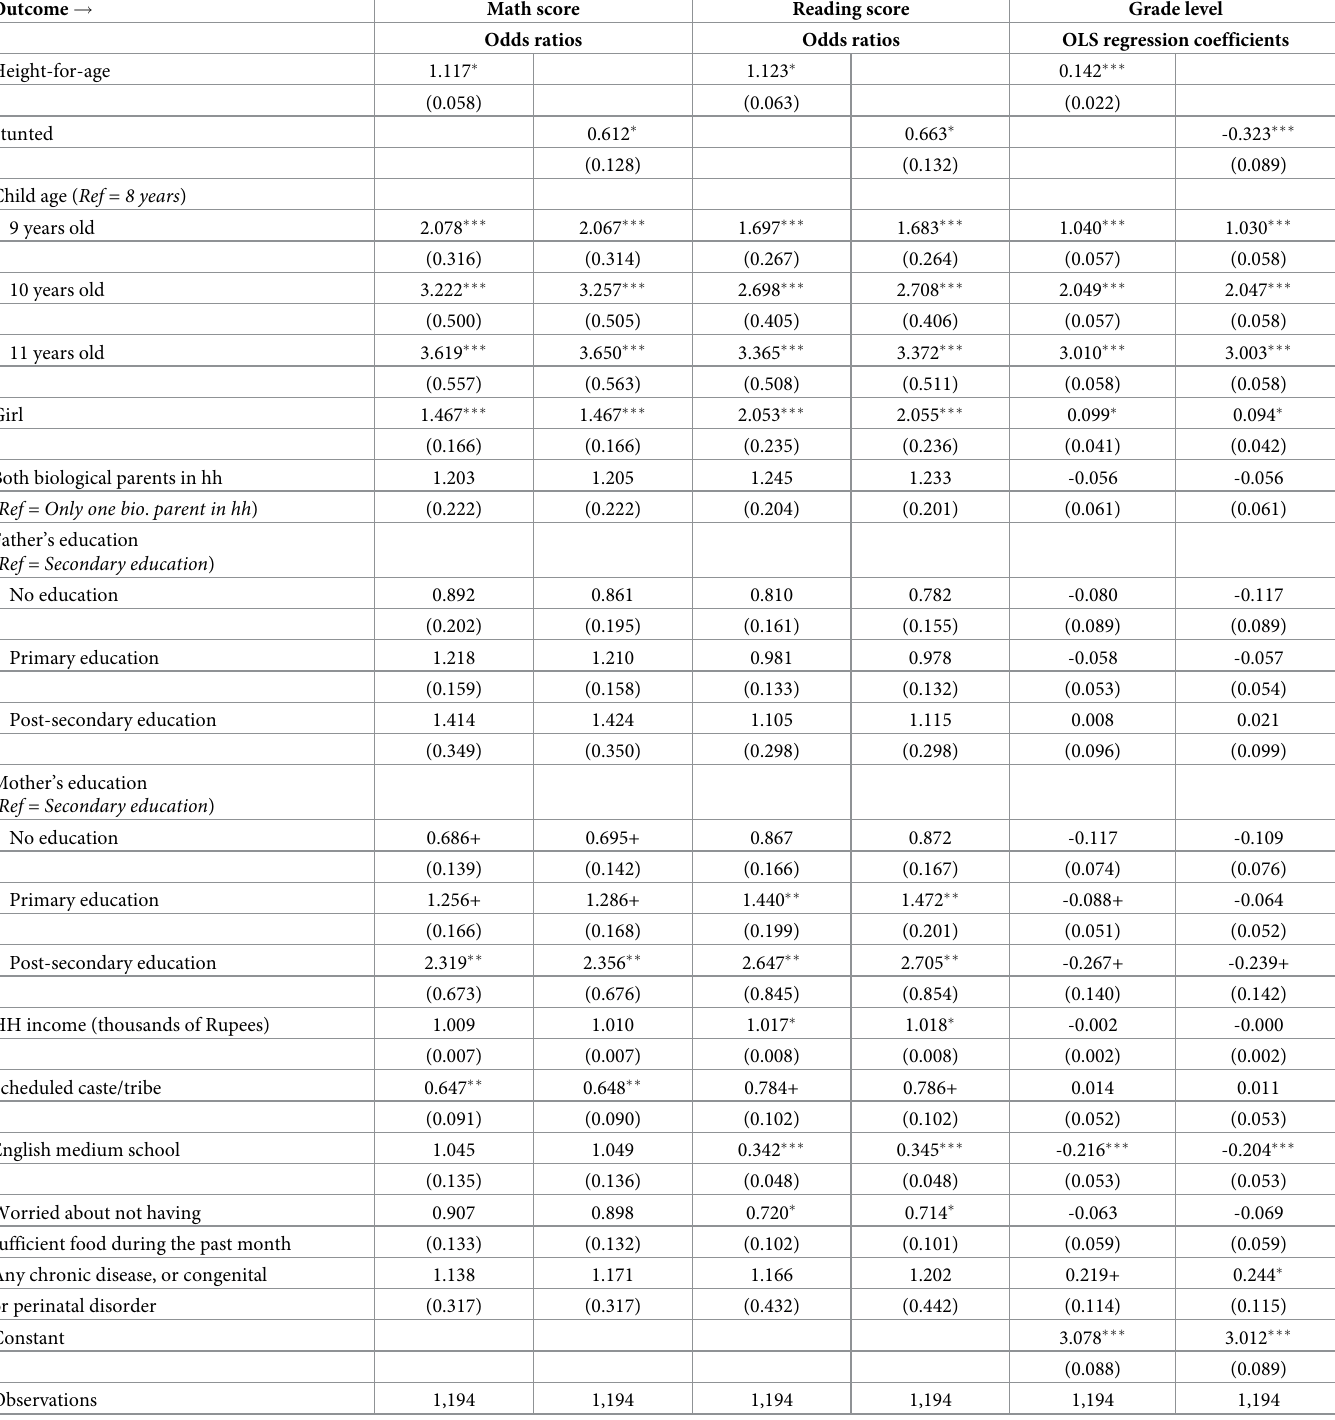
Table 2. Adjusted models for the association between cognitive achievement and educational attainment and height-for-age z-scores and stunting. Outcome